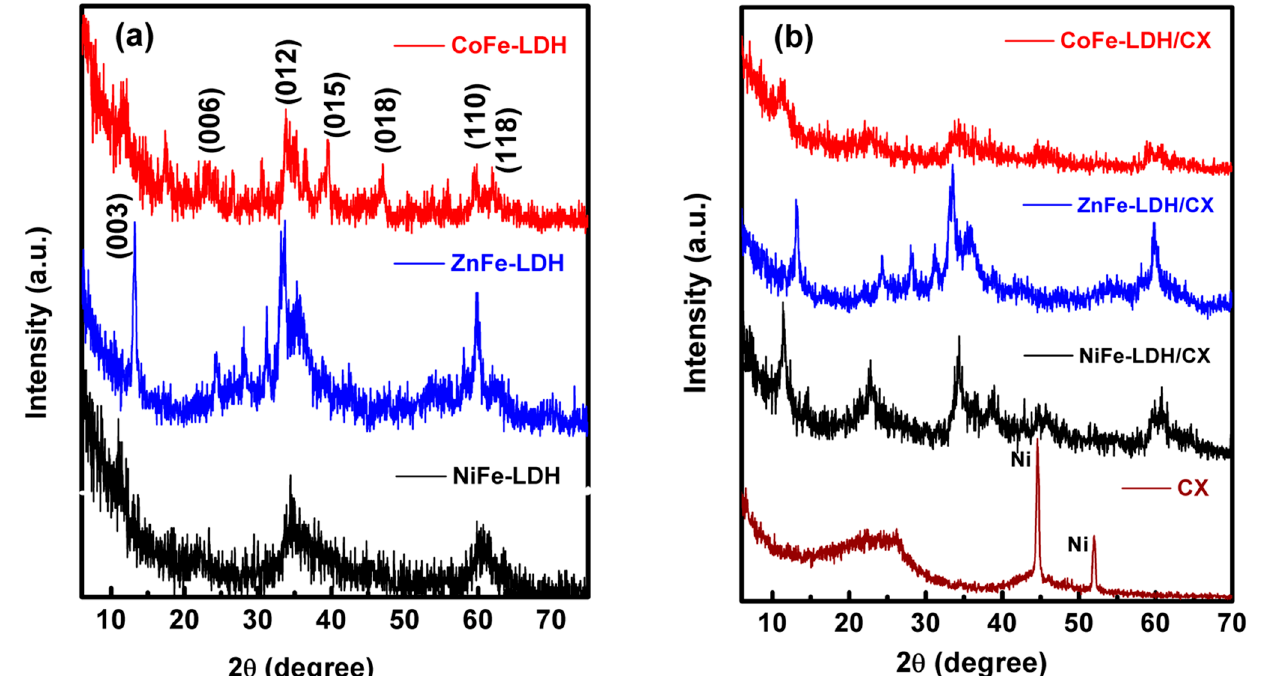
Figure 1. The XRD patterns of ( a ) XFe-LDH/NF and ( b ) XFe-LDH/CX/NF.